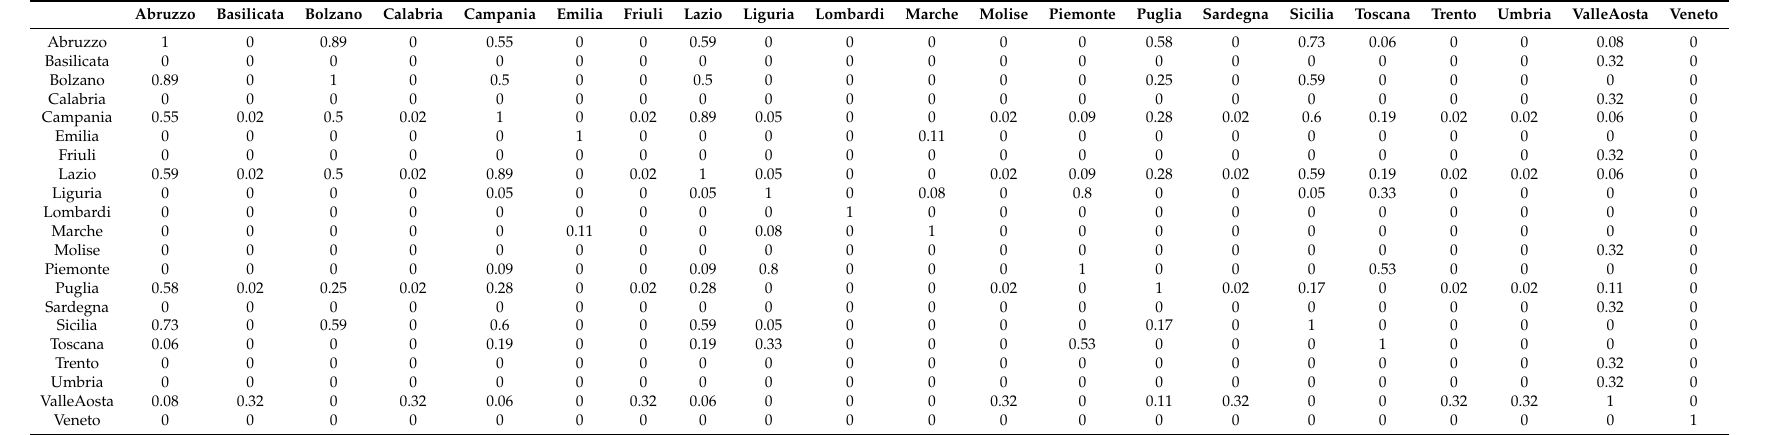
Table A14. Similarity values of Total Hospitalized network in the first